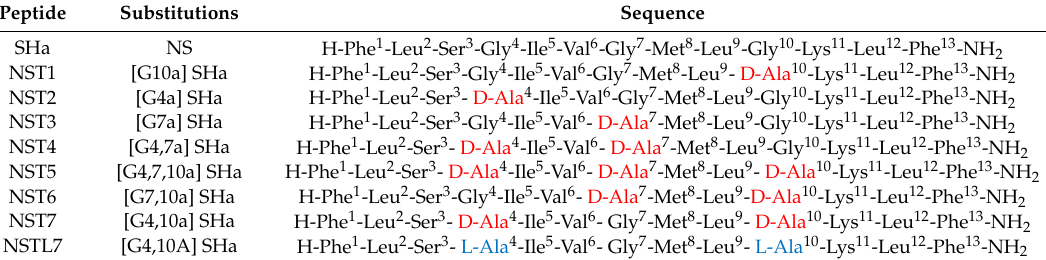
Table 1. Sequence of peptides used in this study. Temporin-SHa (SHa) is the original peptide. Substitution of one Gly or more is shown in red for D-Ala and in blue for L-Ala. NS = no substitution (natural peptide). G4 = Gly at position 4. G7 = Gly at position 7. G10 = Gly at position 10. a = D-Ala. A =